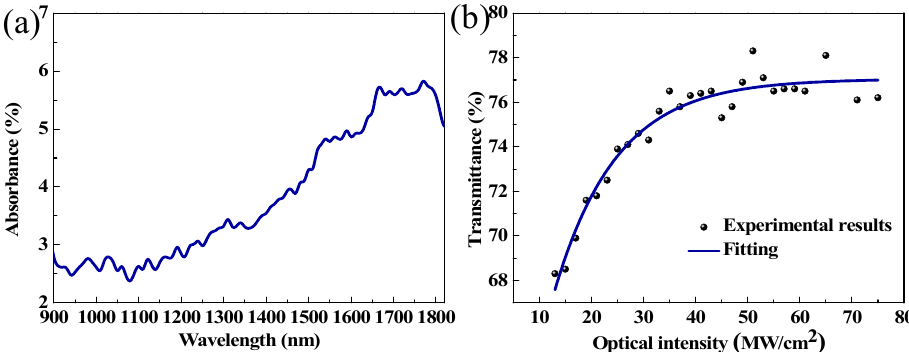
Figure 3. ( a ) The measured linear absorption; ( b ) the measured saturable absorption